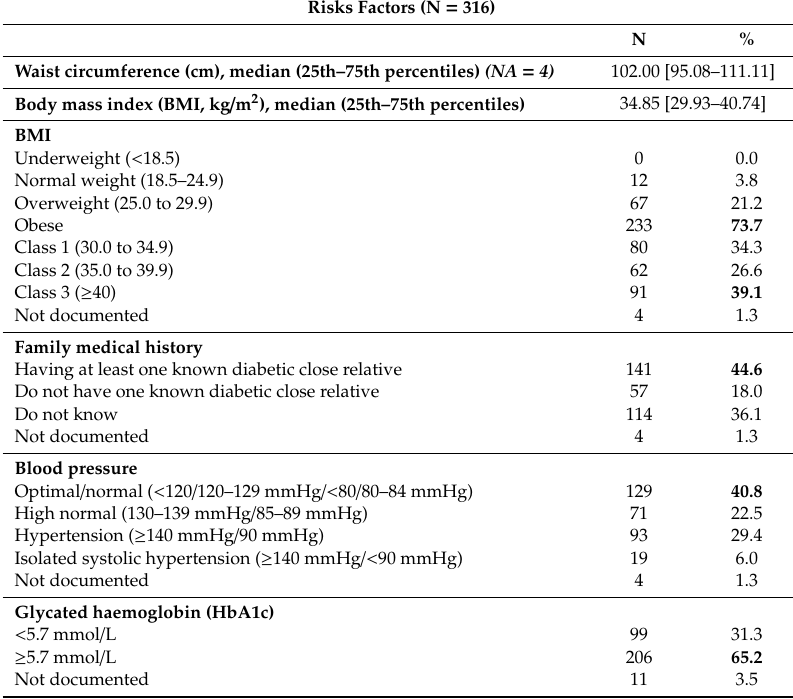
Table 3. Biological and behavioural risk factors for type 2 diabetes among at-risk black and mixed-ancestry communities in Cape Town, 2018 (N =